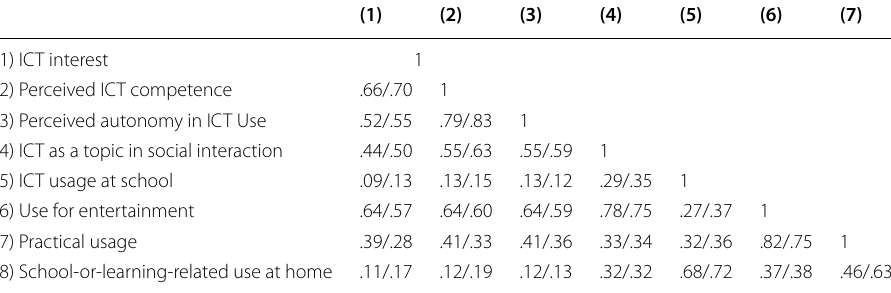
Notes . The coefficients in front of the forward slash refer to values for the Swiss sample, whereas the values after the forward slash refer to the results for the German sample. Model fit for Switzerland: χ 2 Model fit for Germany: χ 2 All correlations were statistically significant ( p <